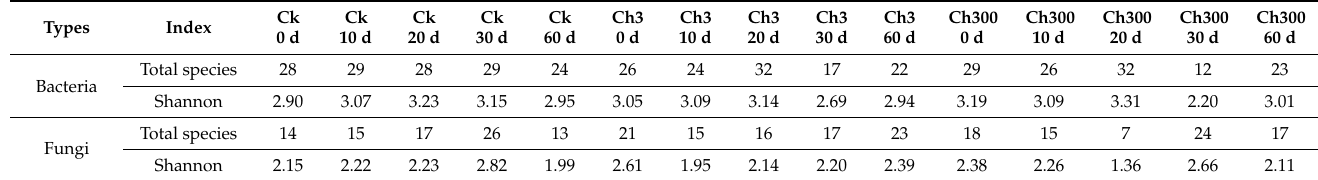
Figure 3. DGGE profile and analysis of soil bacterial and fungal communities: ( a ) Cluster analysis of soil bacteria from the DGGE pattern at different times. ( b ) Cluster analysis of soil fungi from the DGGE pattern at different times. Table 3. Analysis and comparison of the DGGE